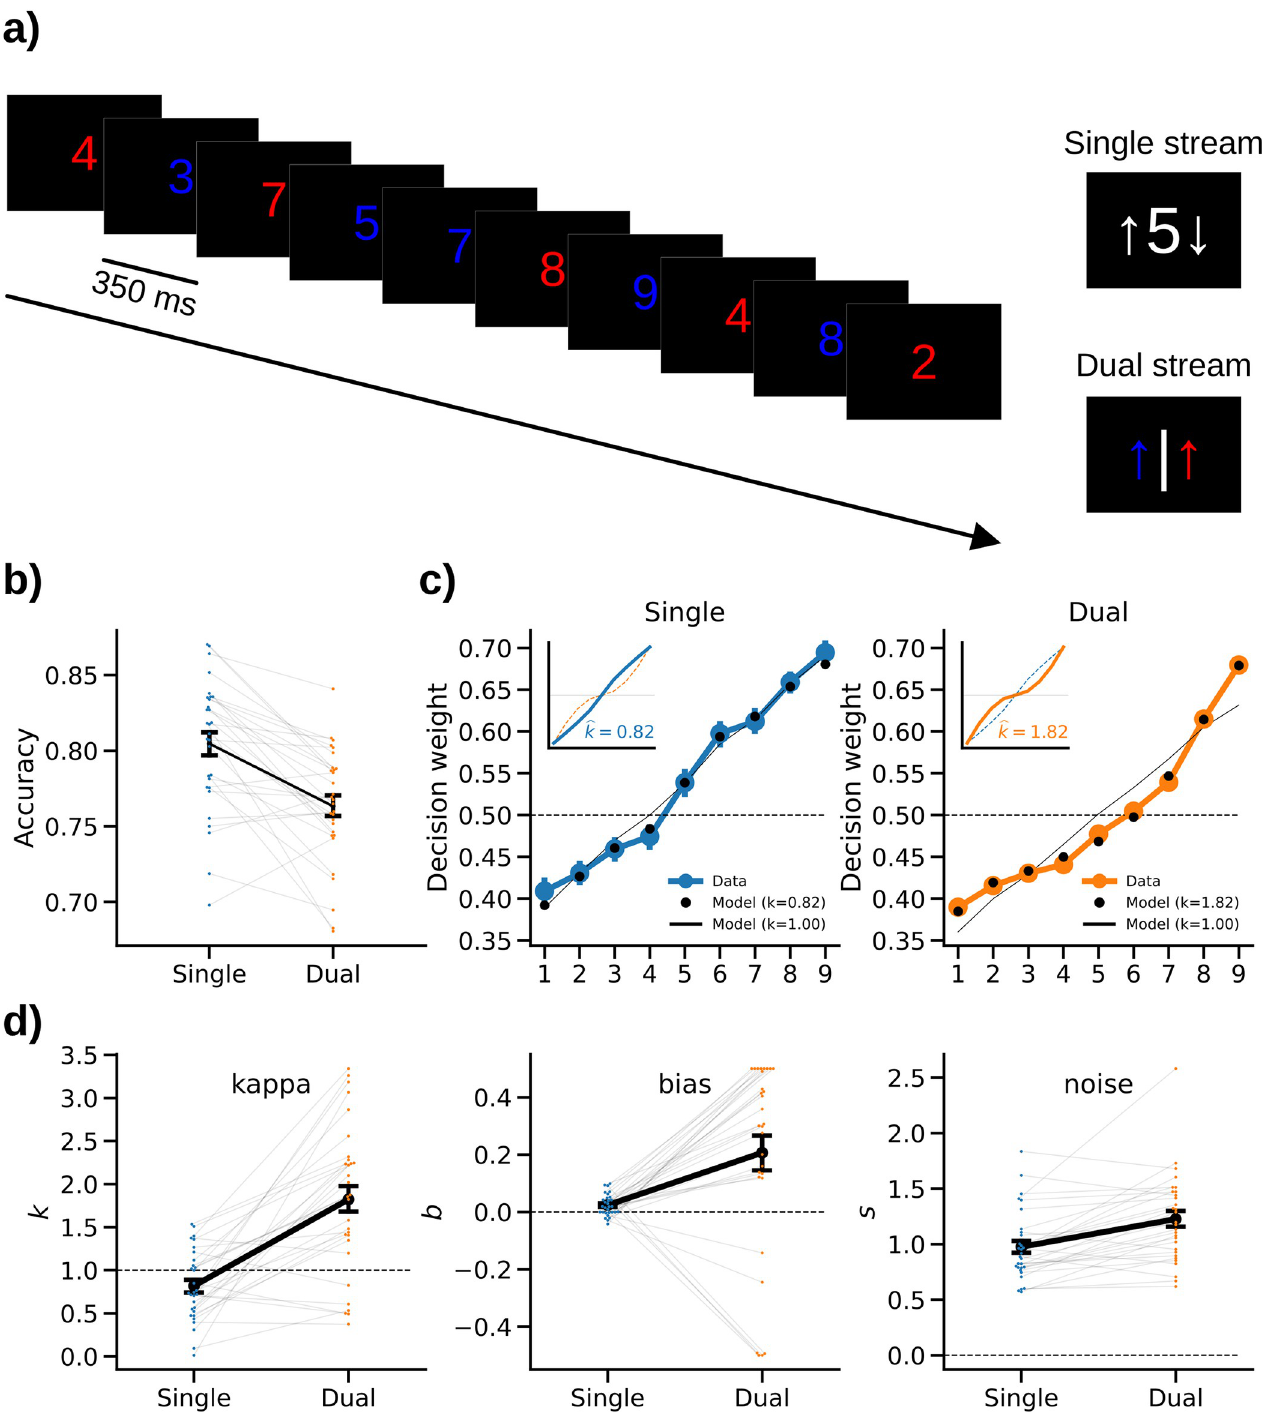
Fig 1. Experimental paradigm and behavioral results. a) Each participant performed two variants of a sequential number integration task. Left : In both variants, participants viewed a stream of ten rapidly presented digits (five in red and five in blue color; in random serial order) drawn from 1 to 9 (uniform random). In the single-stream averaging task, participants were asked to judge whether the average value of all ten samples was higher or lower than 5 (ignoring the samples’ colors). In the dual-stream comparison task, participants were asked to compare the average value of the red samples against that of the blue samples and to report which was larger. Right : In both tasks, the response mapping onto left/right button presses was randomized across trials and cued only after sample presentation, in order to avoid motor preparation confounds. b) Mean accuracy (proportion correct choices) in the two tasks. c) Decision weights of number values in the single-stream (left) and dual-stream (right) tasks. Inset plots illustrate the shape of distortion implied by the best-fitting k (see panel d )